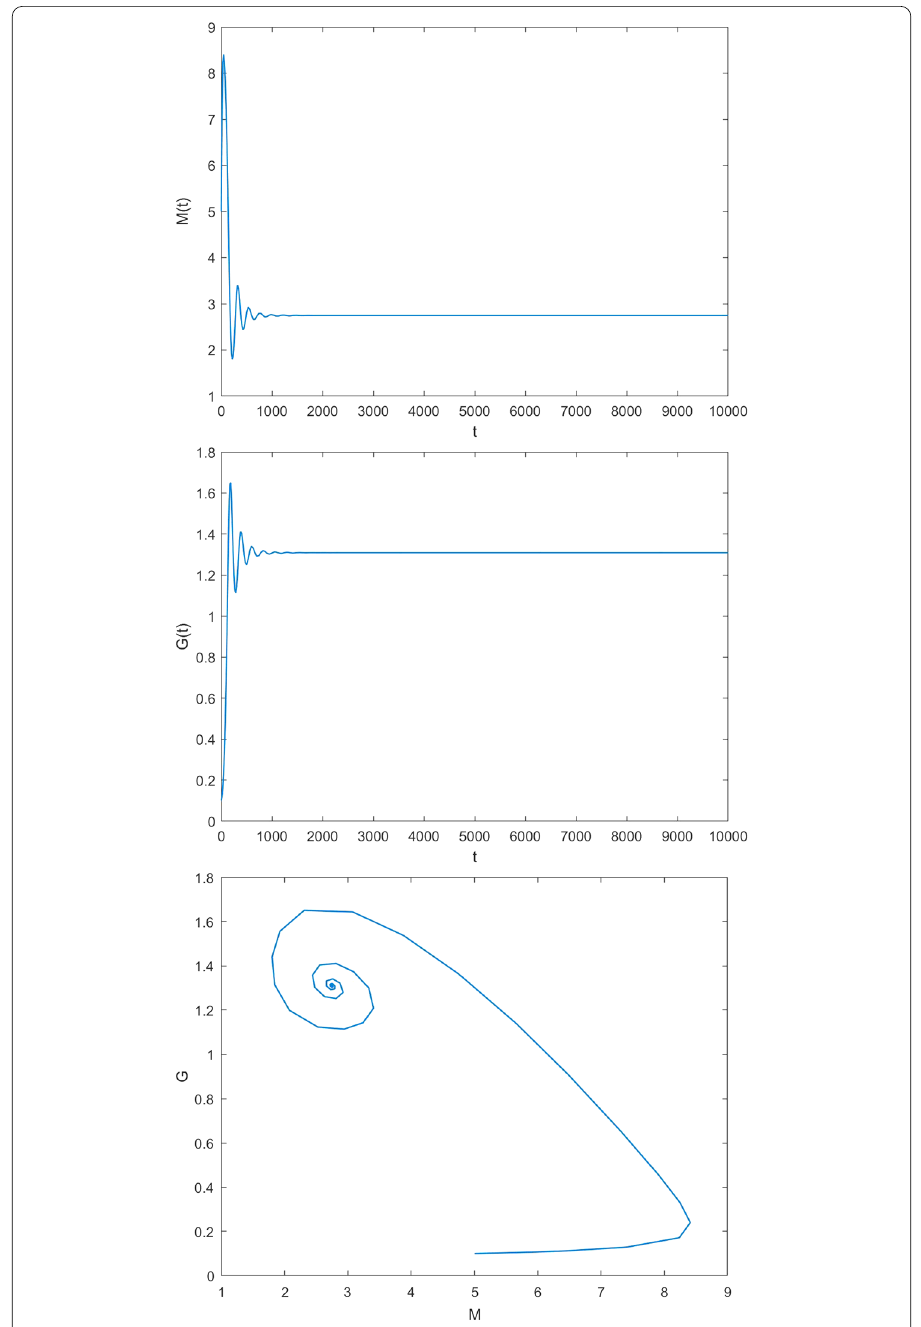
Figure 2 A computer simulation of the system (2.1)–(2.2) with a 1 = 0.1450, a 2 = 0.6937, b 1 = 0.0596, b steady state as theoretically predicted